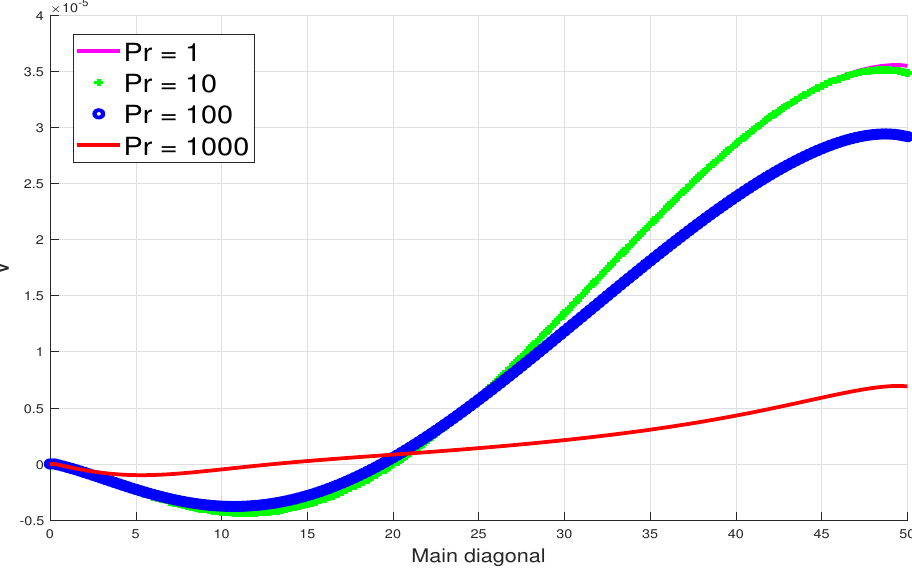
Figure 24. Transverse velocity dependence on Pr at t = 5.